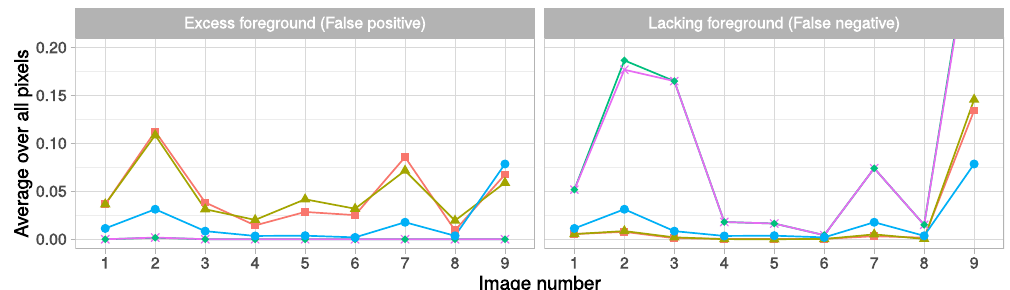
Figure 6. Comparison of the thresholding methods. The Expert average measures the variation between the experts and gives a reasonable bound for the obtainable